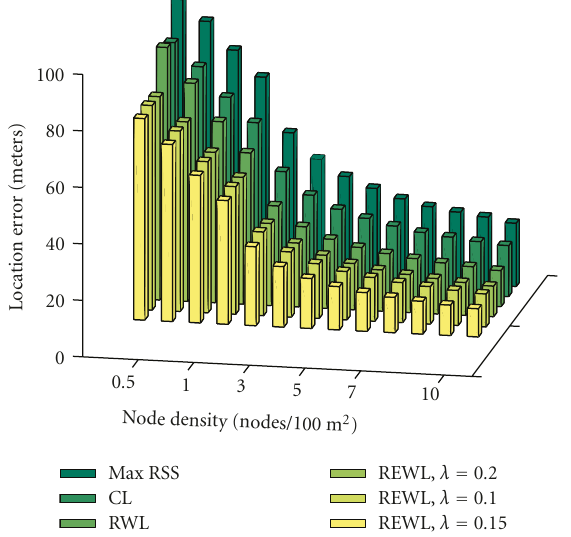
Figure 4: Algorithm location error by node density for 5.8 GHz.